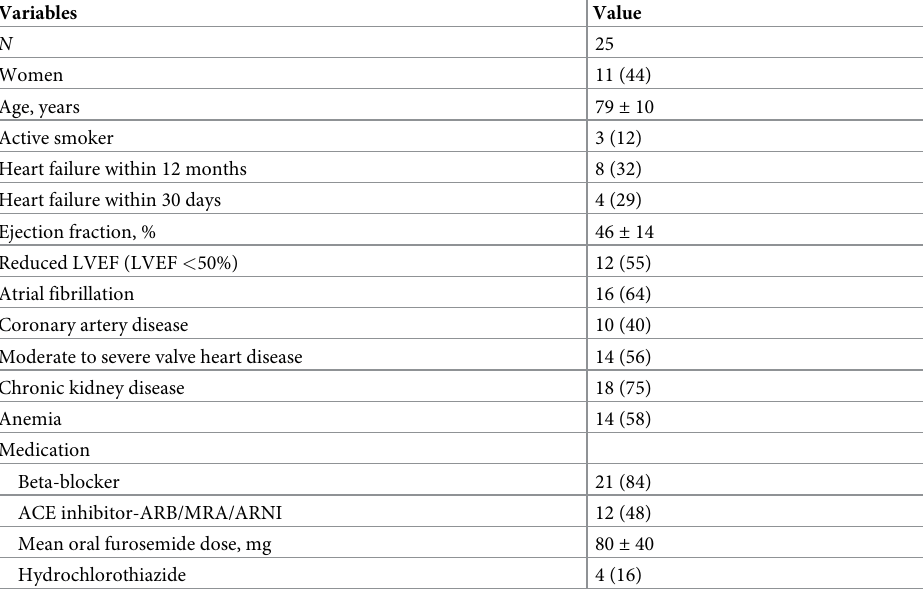
Table 1. Baseline clinical and demographic characteristics of heart failure patients.